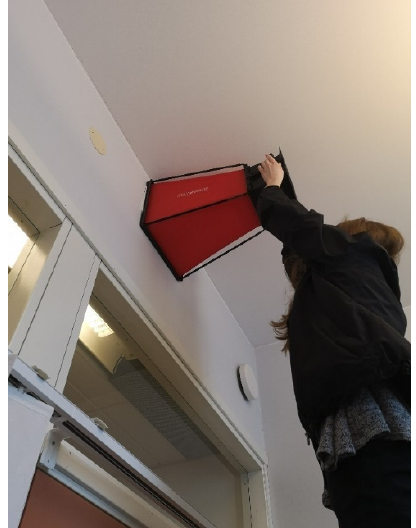
Figure 14. Show the airflow probe being used for measuring the ventilation flow rate of the supply device in room A. device in room A.